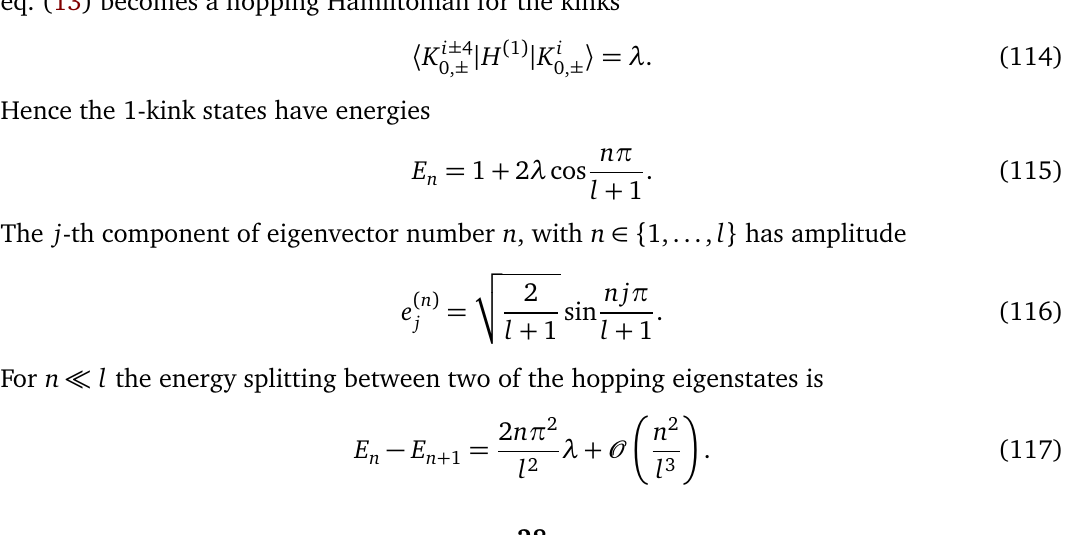
Figure 6: The energies of the six one kink states in the M σ / σ BC (no 0 / no 0) , staggering λ 1 λ 1... λ